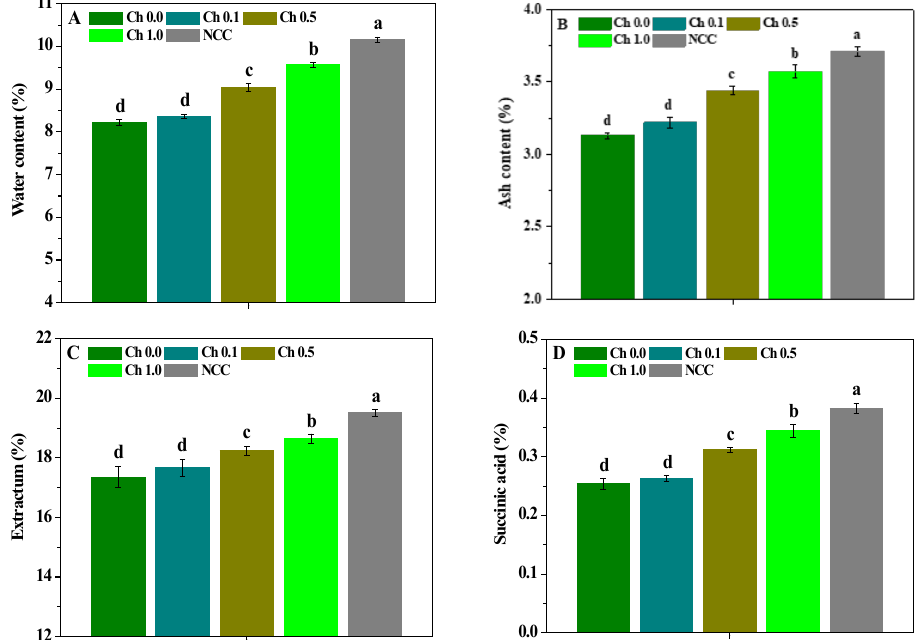
Figure 5. The influence of chitosan spraying on the water ( A ), ash ( B ), extractum ( C ), and succinic acid ( D ) of P. ternata . Error bars show SD, and different letters indicate significant differences at 5% ( p < 0.05) level.